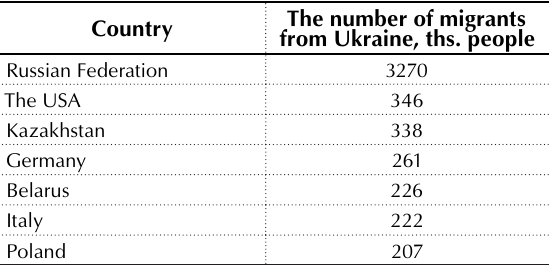
Table 1. The main countries-recipients of Ukrainian migrants from 2000 to 2015